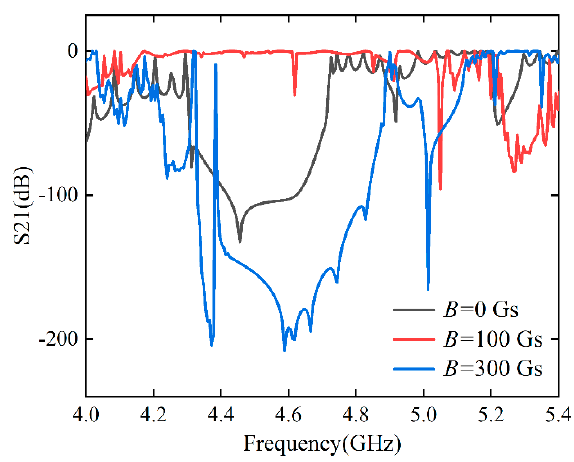
Figure 4. The transmission spectra of the PPC at different magnetic fields considering TE polariza- tion.